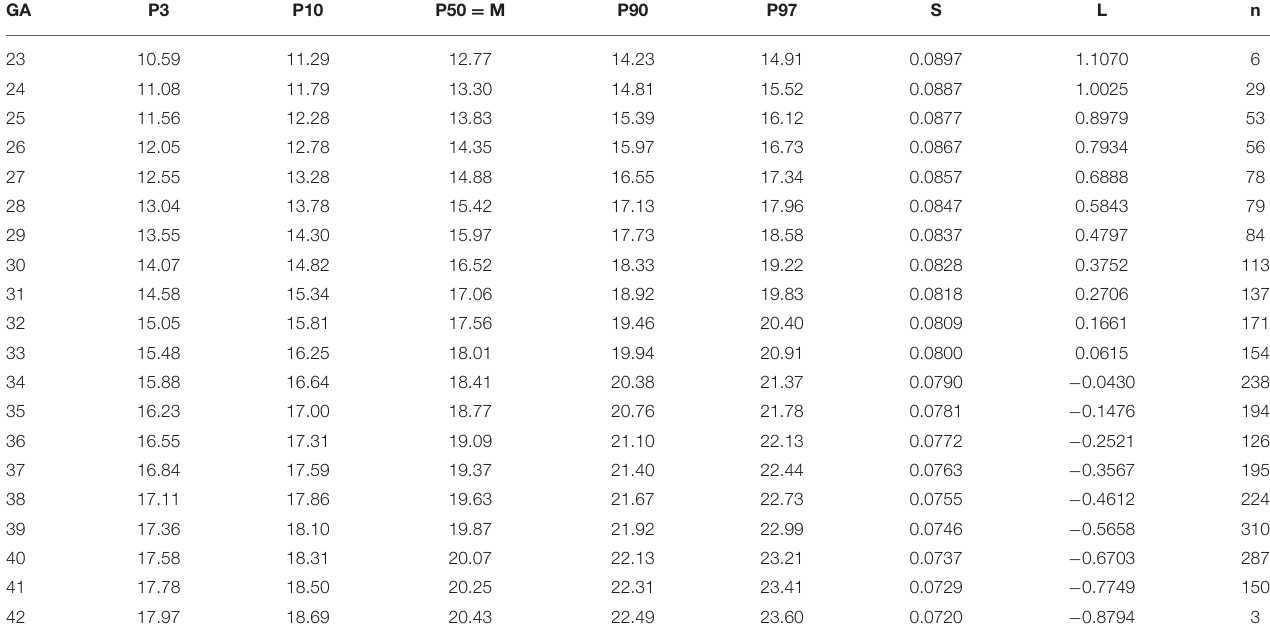
TABLE 2 | LMS parameters of models of transfontanellar EED (fEED) for boys.